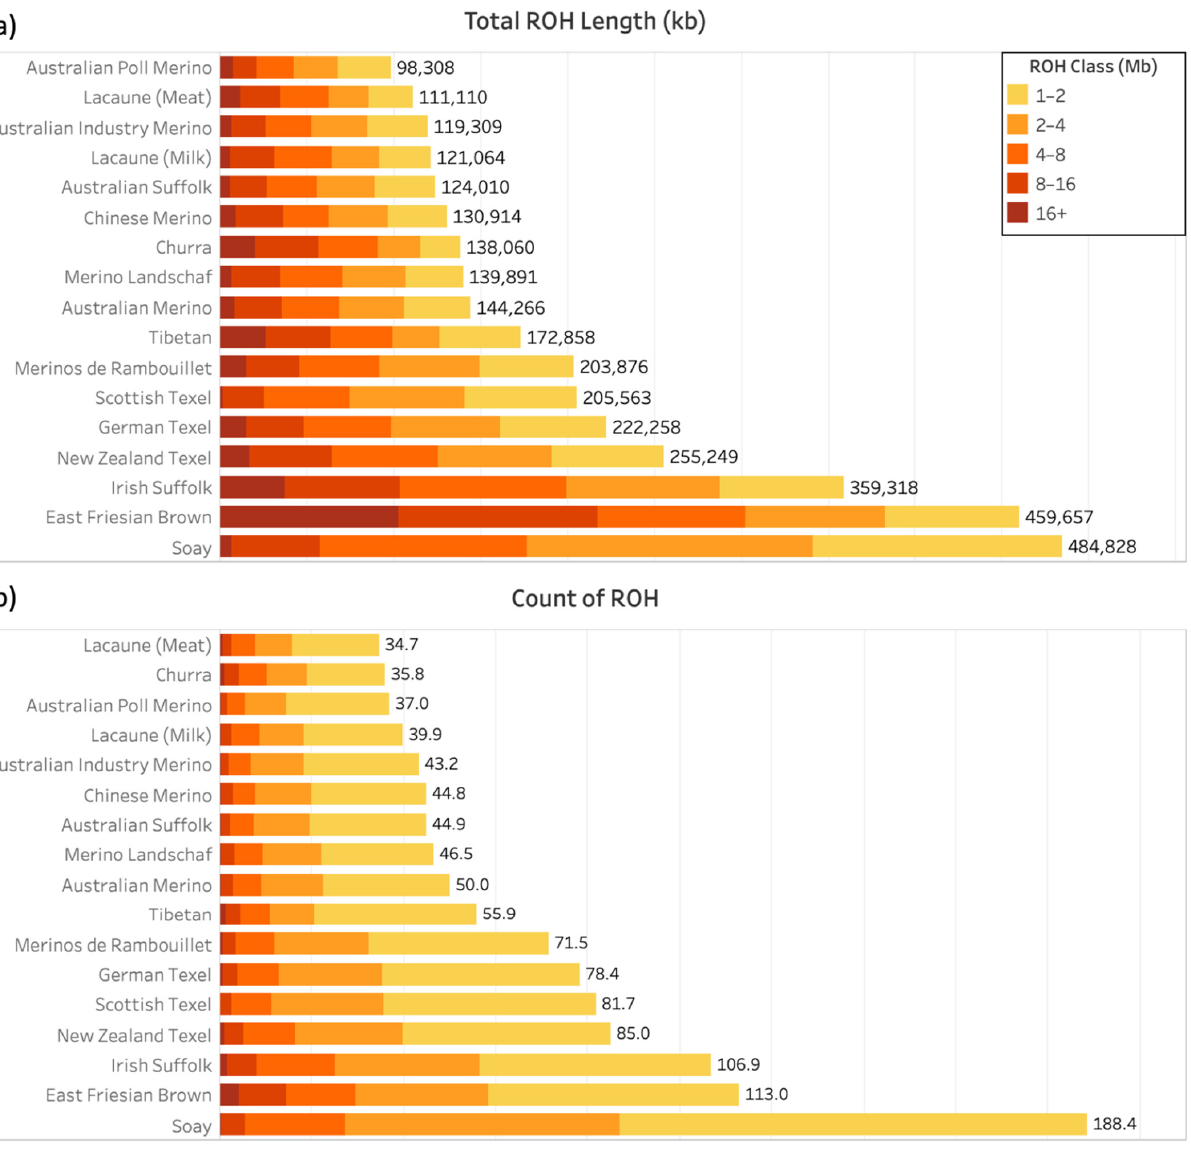
Figure 1. Distribution of ROH on seventeen worldwide sheep populations. ( a ) Populations average of genomic ROH length (top figure); ( b ) populations average of the number of ROH on the genome. Color scale represents the length of the runs in Mb, divided into five classes (1–2, 2–4, 4–8, 8–16, and >16 Mb). Figure 2 provides an example of population averages of the proportion of ROH cov- erage in each chromosome for five populations. The results for all the other populations are presented as Supplementary Material (File S1). Australian Poll Merino and Tibetan had low percentages of ROH coverage on all chromosomes (less than 10%), while East Friesian Brown and Soay had over 20% in some chromosomes. However, ROH longer than 16 Mb were more frequently detected in the East Friesian Brown than in the Soay population (Figure 1). Scottish Texel had relatively few ROH longer than 16 Mb, whereas Tibetan, also with a low percentage of ROH coverage, had a greater amount of long ROH (mainly located in chromosomes OAR7, OAR16, OAR22, and OAR25). The distribution of ROH across chromosomes also varied among populations, as some had a significant amount of ROH coverage on a given chromosome and others had a small amount on that same chromosome.